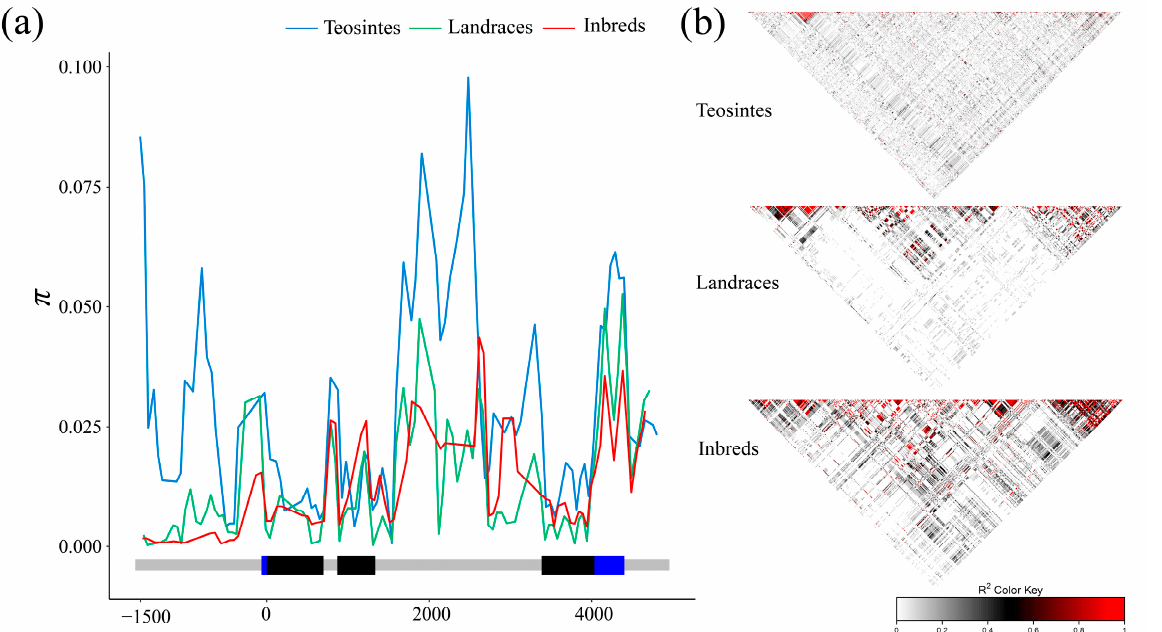
Figure 1. Nucleotide diversity of inbred lines, landrace, and teosintes. ( a ) Nucleotide diversity ( π ) of inbred lines, landraces, and teosintes. π was calculated using the sliding windows method with a window size of 100 bp and a step length of 25 bp; ( b ) linkage disequilibrium (LD) model of ZmCKX5